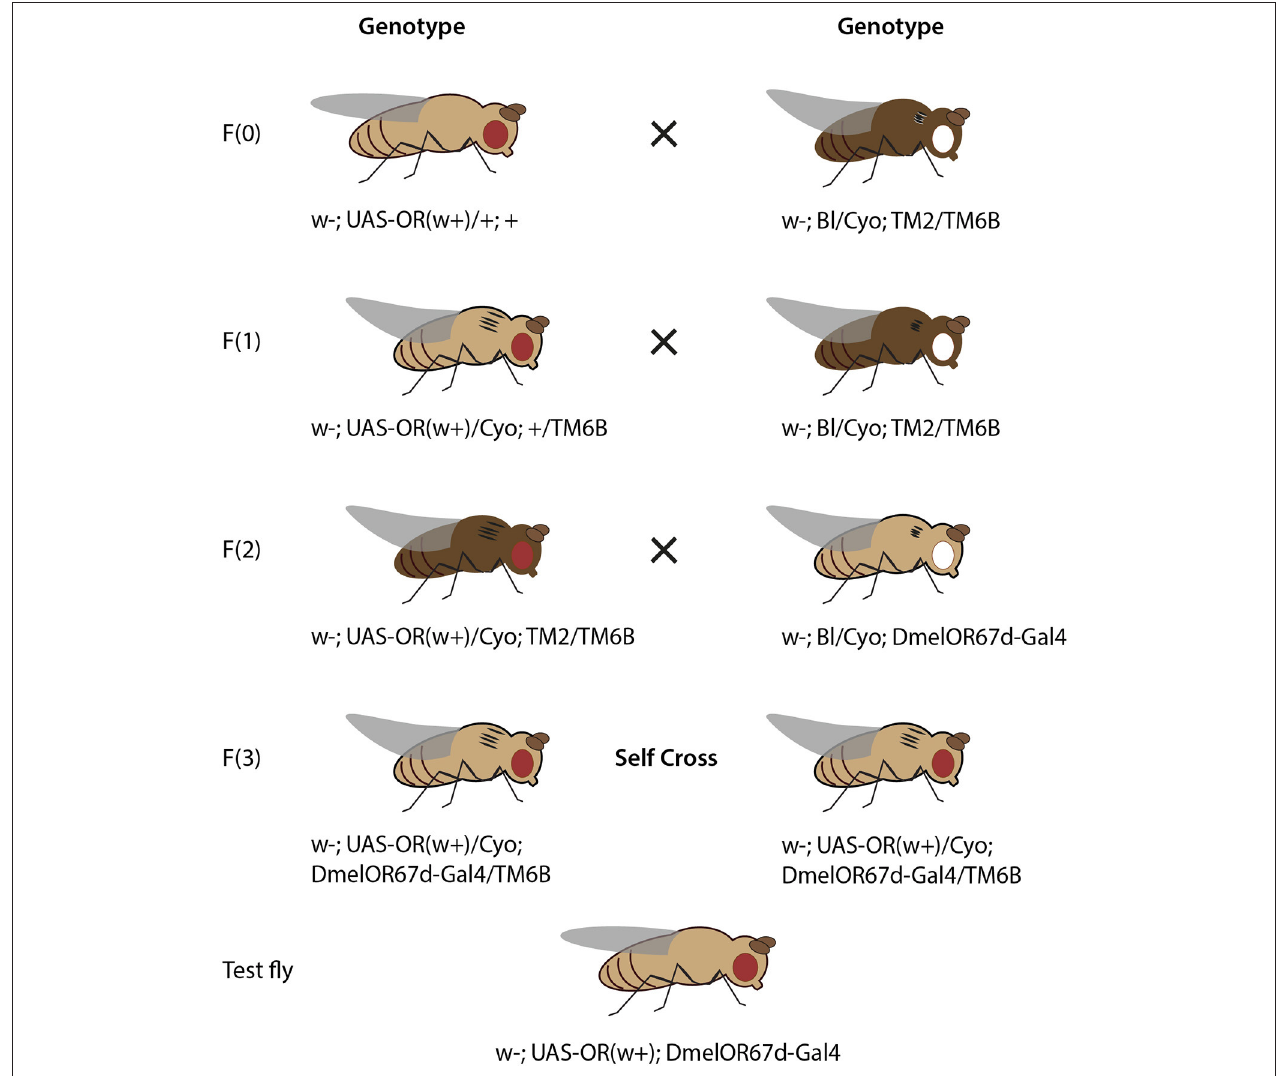
FIGURE 3 | Crossing scheme for heterologous expression of an OR transgene in OSNs in T1 sensilla, using DmelOR67d-Gal4 knock-in with knock-out of DmelOR67d coding sequence. Fly drawing by Katarina Eriksson